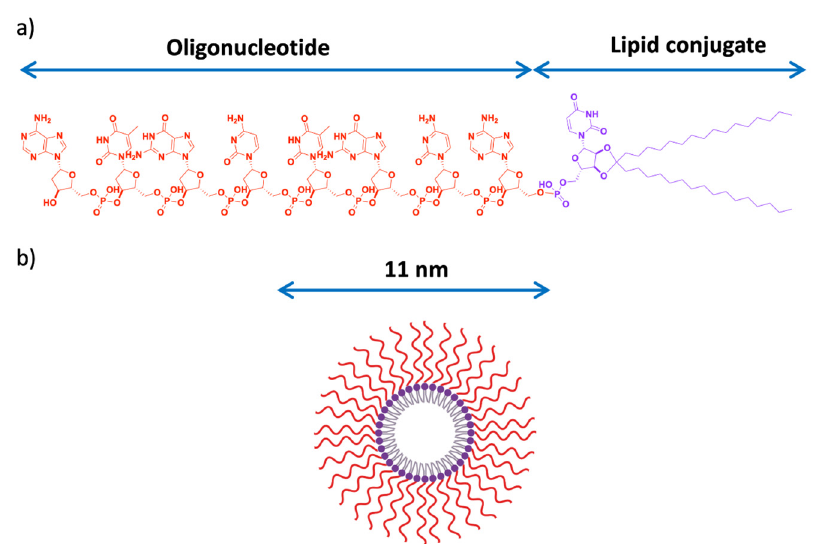
Figure 7. ( a ) Lipid-conjugated Antisense Oligonucleotide (LASO) structure; ( b ) Auto assembly— micelle formation of LASO in aqueous media; with a particle size of 11 nm. Adapted from [141], Elsevier, 2017.